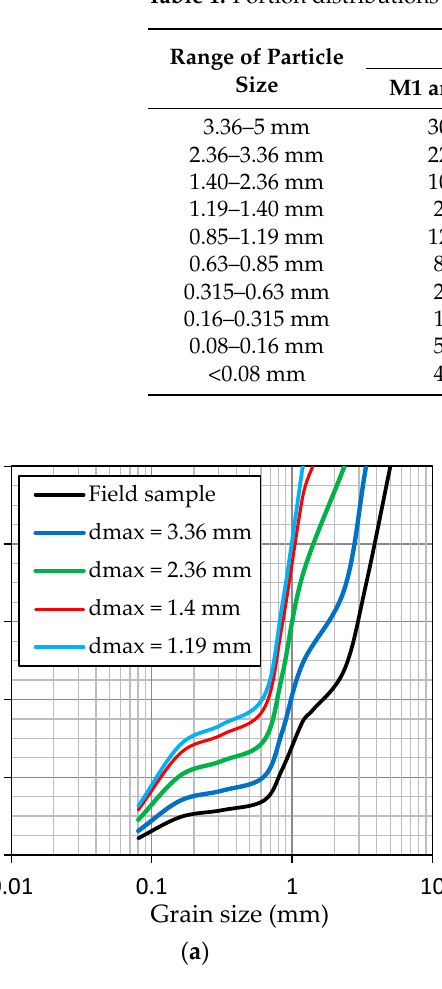
Figure 3. PSDCs of scalped samples of field sample M1 and M3 ( a ) and M2 ( b ).